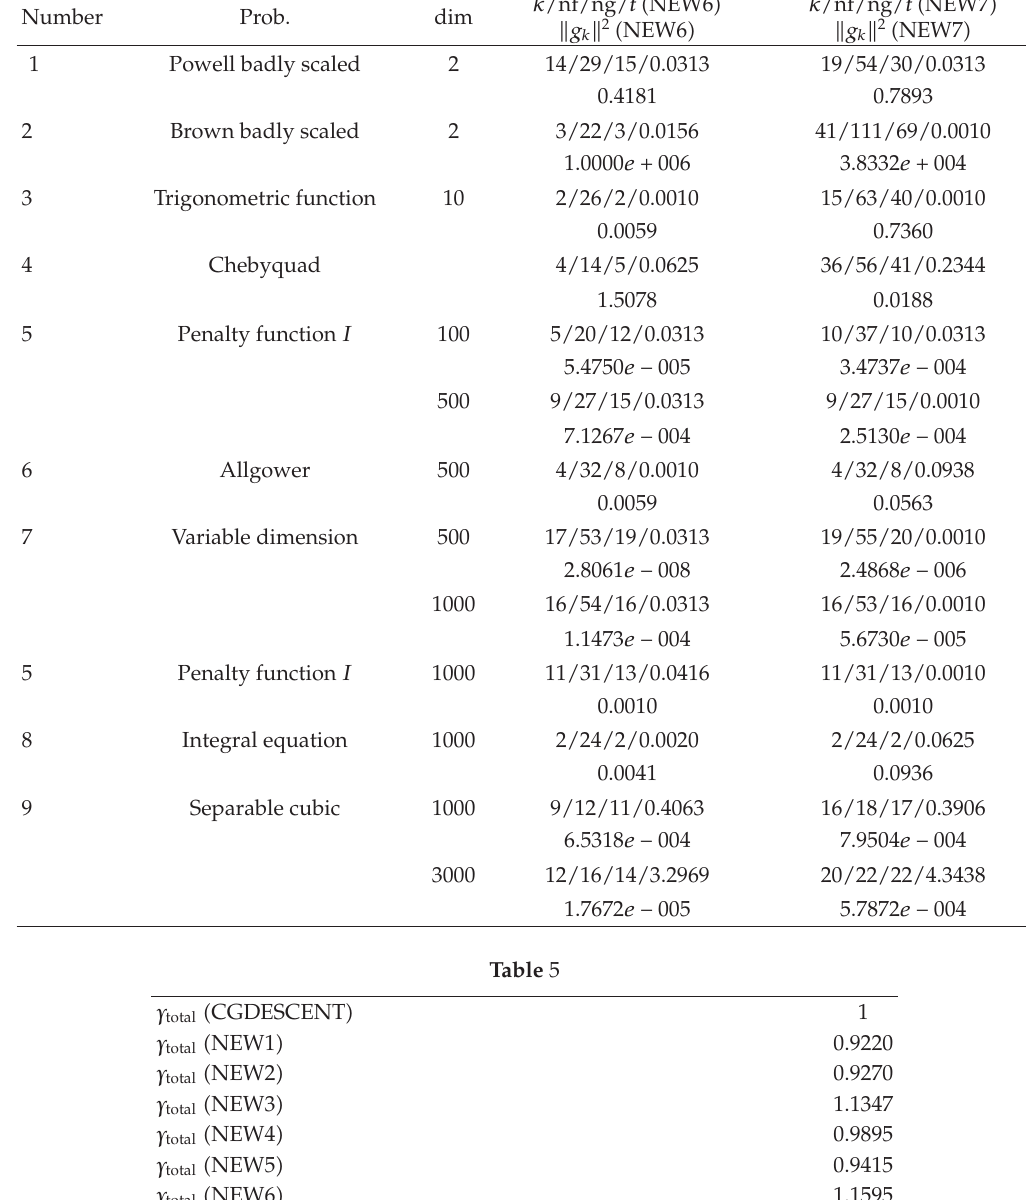
Table 4: Numerical results of the NEW6 and